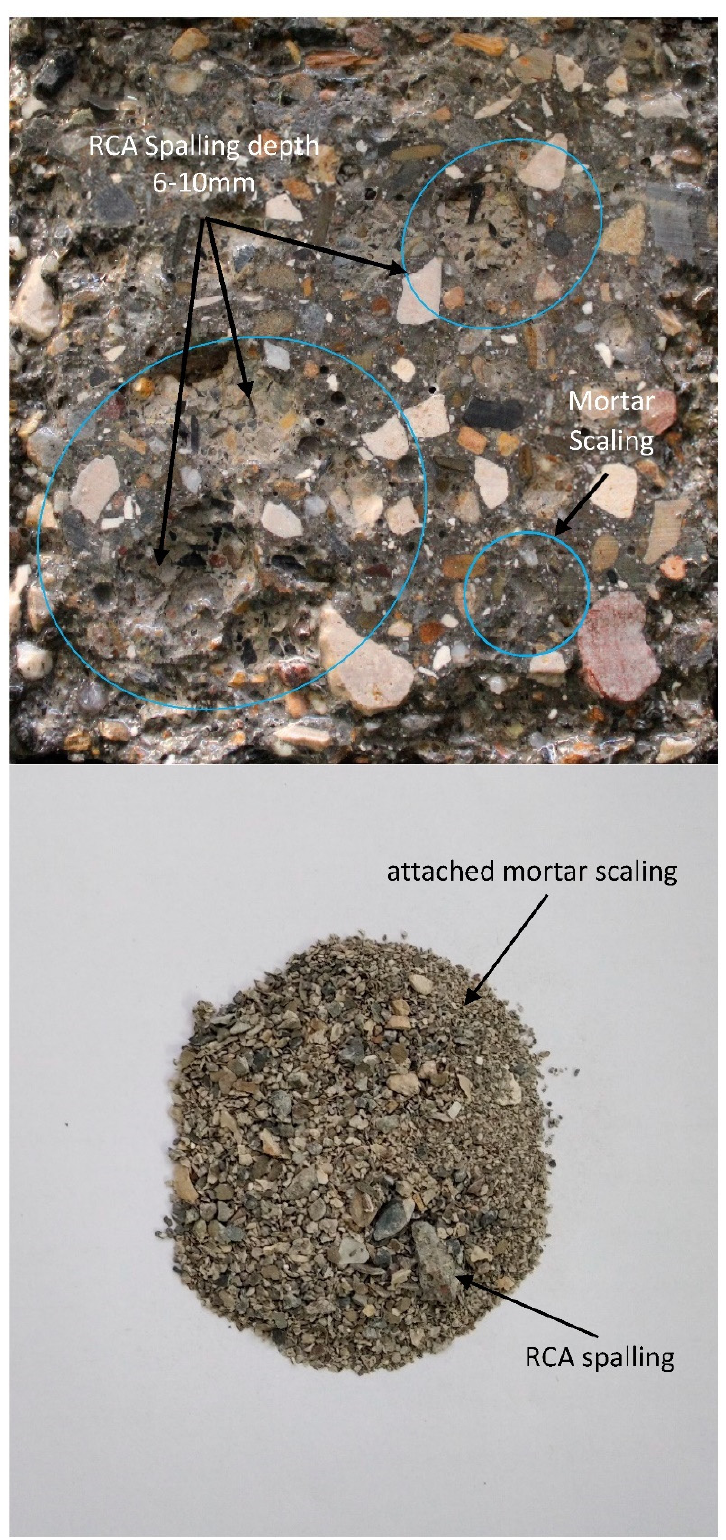
Figure 8. RCA spalling and mortar scaling of mix containing recycled concrete aggregate.